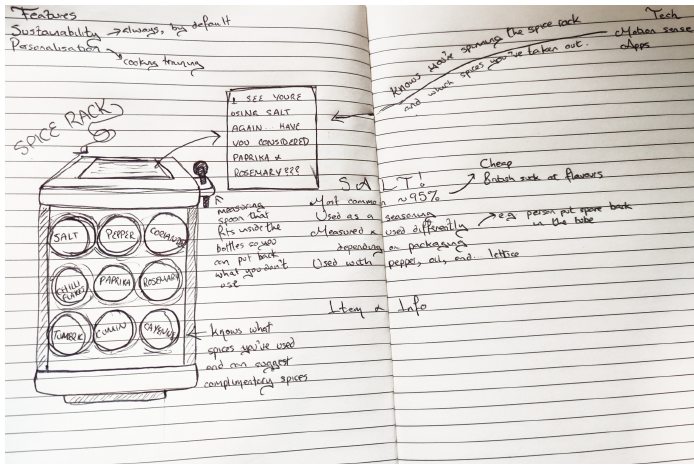
Figure 4. Design by P22 of a “smart spice